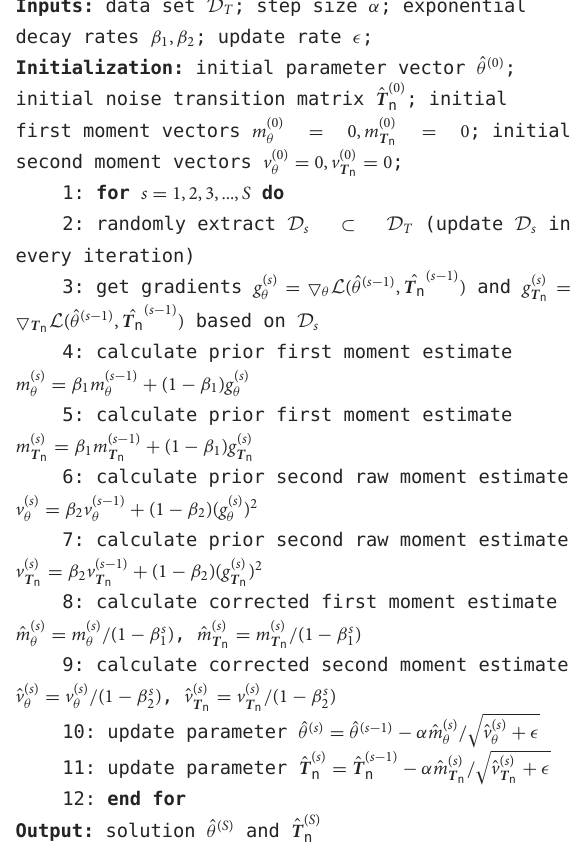
Algorithm 1. One-step algorithm for estimating ˆ T n and ˜ p ( y | x , θ ) based on stochastic gradient